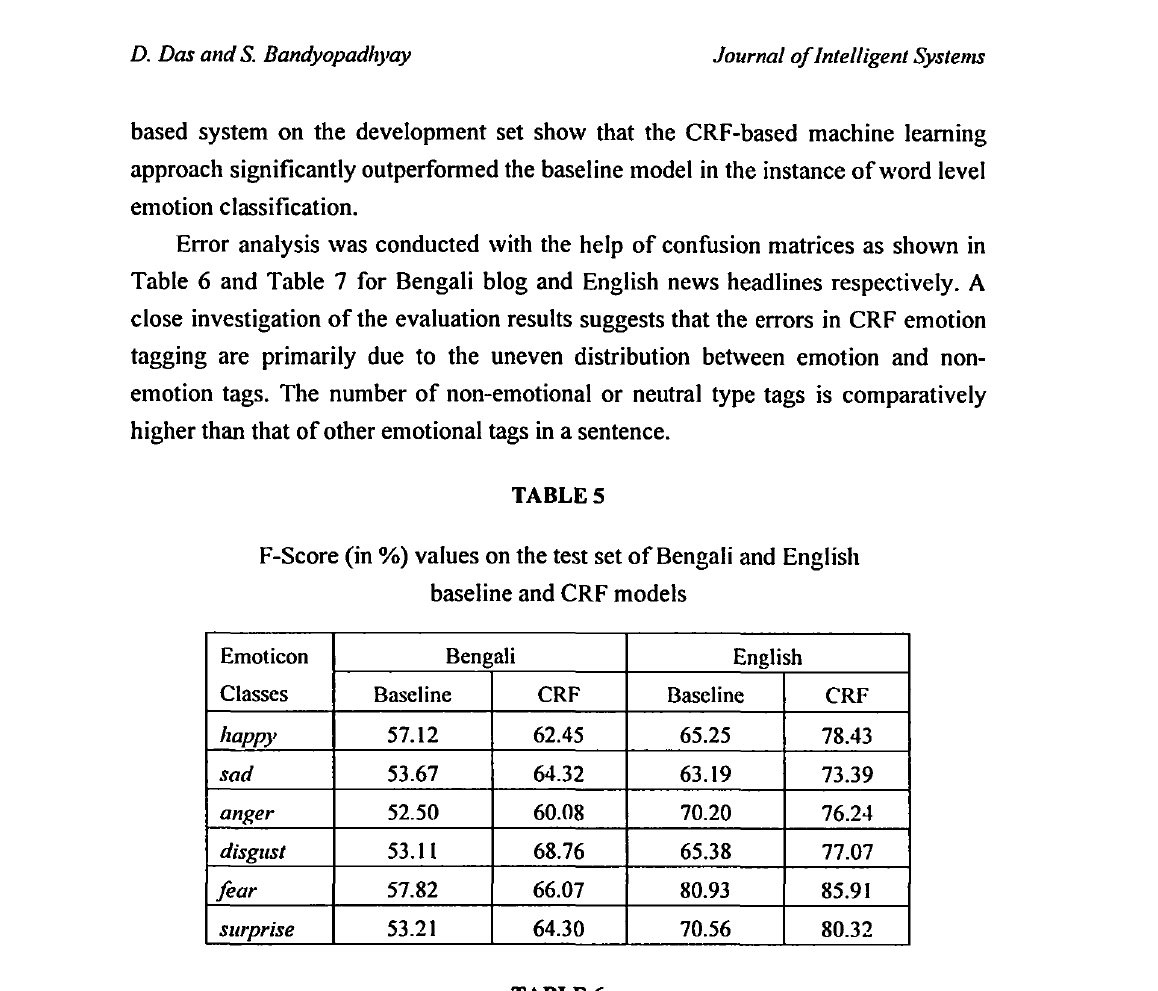
F-Score (in %) values on the test set of Bengali and English baseline and CRF models